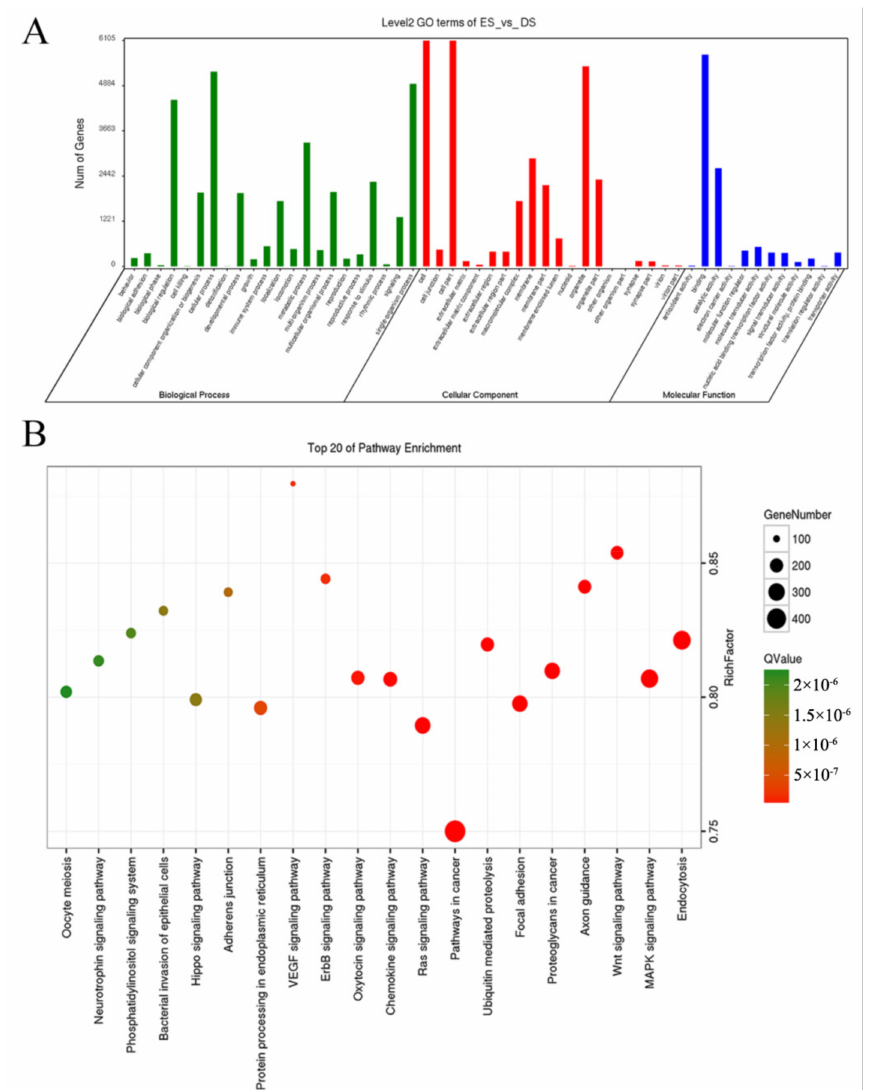
Figure 3. GO and KEGG enrichments of predicted target genes of differentially expressed miRNA. ( A ) The enriched GO terms of differentially expressed miRNA target genes, and ( B ) the enriched KEGG pathways of differentially expressed miRNA target genes. To assess the function of differentially expressed miRNA in different stages of estrous cycle, the target genes of the miRNAs were predicted, and GO enrichment ( A ) and KEGG enrichment ( B ) were